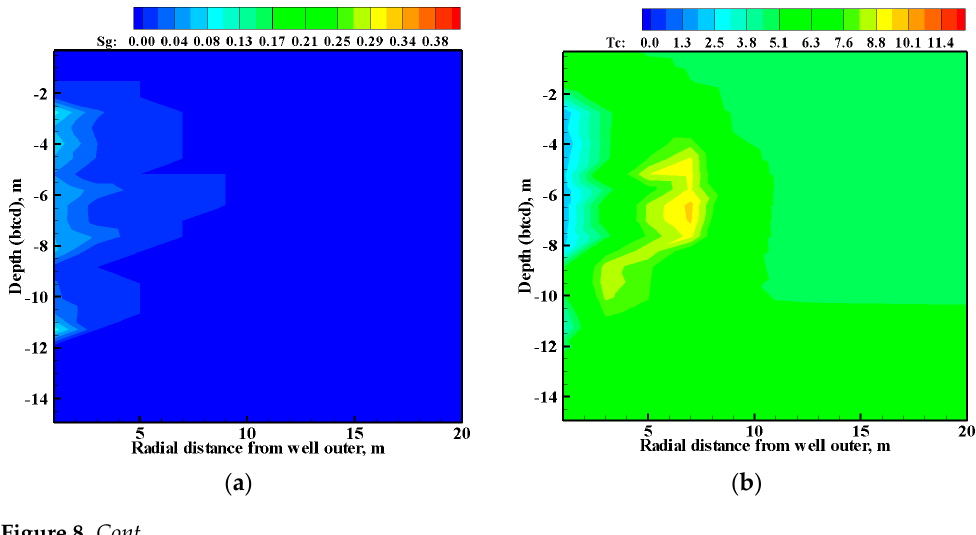
2 and N 2 during the injection.